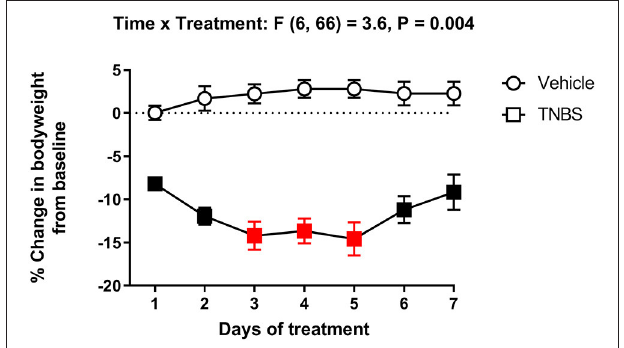
FIGURE 3 | Effect of TNBS treatment on body weight. Percent change in body weight from baseline of mice treated with vehicle or TNBS. TNBS significantly reduced body weight that peaked on Day 3. Recovery of the lost body weight was observed starting Day 6. Filled points represent statistical significance ( P < 0.05) vs. vehicle as indicated by a significant time x treatment interaction in the two-way repeated measures ANOVA with Bonferroni’s test. Data are mean ± SEM. Vehicle ( N = 6/day); TNBS ( N = 7/day). Red points indicate significance ( P < 0.05) vs. day one by repeated measures two-way ANOVA with Dunnett’s